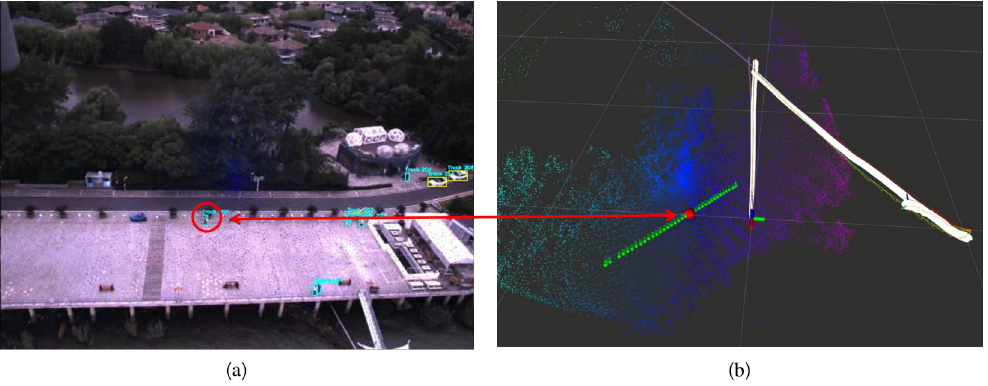
Figure 18. The display image of the tracking effect. ( a ) shows the real-time tracking result, and after a target is selected, the target is indicated by a red ball in ( b ). The green in ( b ) represents ground truth, and the white color is the aircraft’s trajectory calculated by our SLAM.